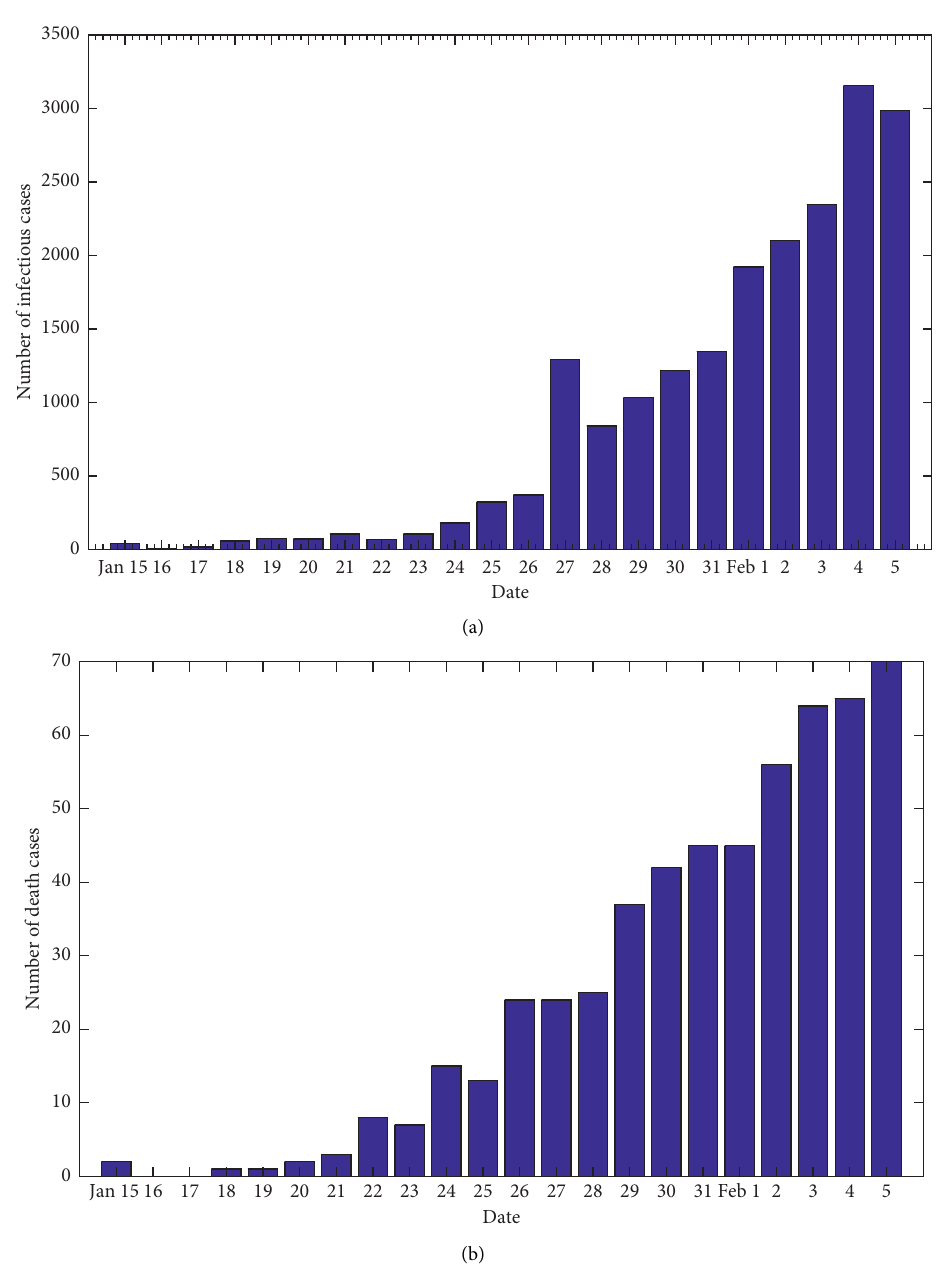
Figure 2: Numbers of confirmed and death cases in Hubei province, from 15 January 2020 to 5 February